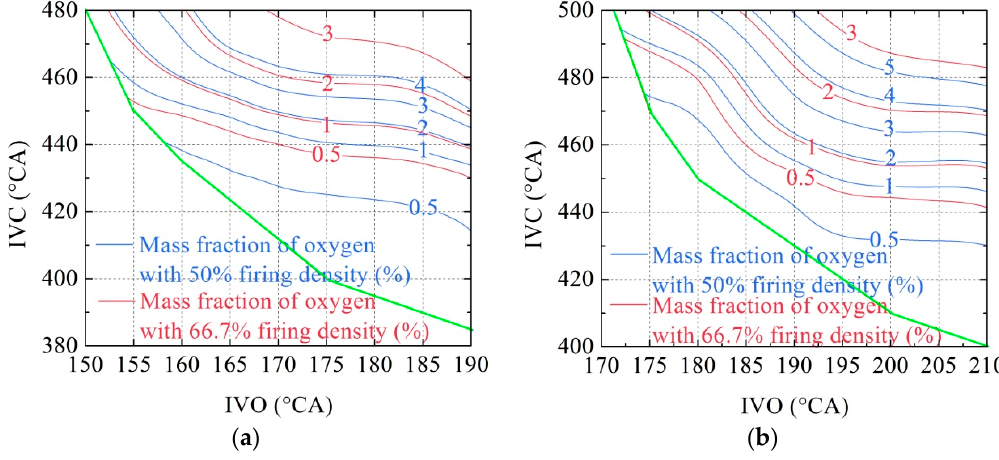
Figure 16. Mass fraction of oxygen in the upstream of catalyst convertor: ( a ) 1200 rpm; ( b ) 1600 rpm.